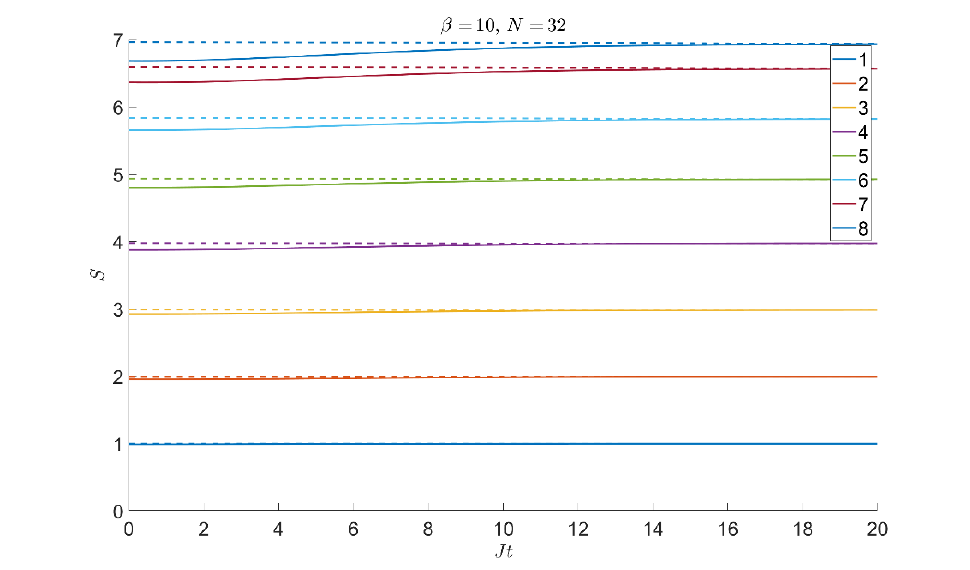
Figure 20 . The solid lines are the entropies of di(cid:11)erent sized subsystems as a function of time for N = 32 Majoranas in a single SYK cluster ( L = 1) with (cid:12) = 10. The dashed lines show the same subsystem entropies in a random state which has been evolved in imaginary time as a proxy for the thermal entropy. After a short time of order (cid:12) , all subsystem entropies have reached their late time thermal values.